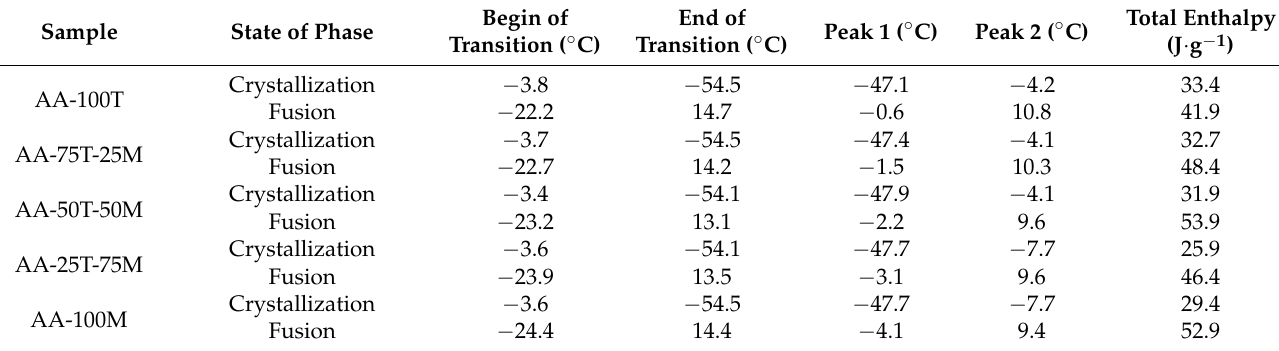
Table 4. DSC results for crystallization and fusion in the five